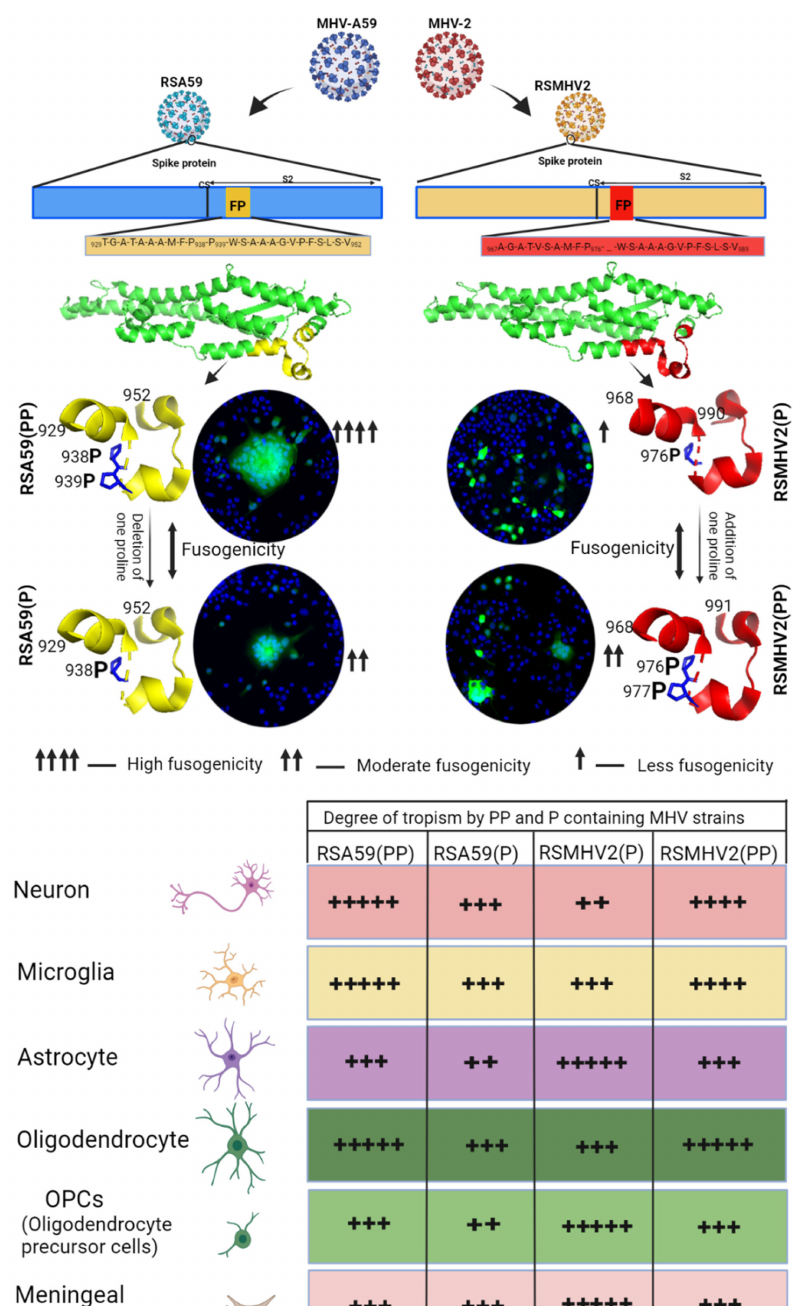
Figure 12. The monomeric model of the S2 subunit of Spike protein of MHV-A59, MHV-2 with their fusion peptides, the mutation and their fusogenicity and neuro-glia tropism. The cartoon diagram showed that RSA59(PP) and RSMHV2(P) were recombinant viruses engineered from MHV-A59 and MHV-2 respectively. Monomeric model of S2 subunit of MHV-A59/RSA59(PP) amino acid residues (871-1116) from PDB structure 3JCL and the S2 subunit of MHV-2 built from 3JCL for MHV-2/RSMHV2(P) amino acid residues (911-1153). The fusion peptide region highlighted in yellow and red for RSA59(PP) and RSMHV2(P) respectively, with the central proline shown in stick model. The deletion of one proline from RSA59(PP) and addition of one proline to RSMHV2(P) resulted into RSA59(P) and RSMHV2(PP), respectively. The fusogenic ability of the four viruses in N2A (neuroblastoma) cell line is indicated by up arrows with strength given in legend. The differential degree of neuroglia tropism by the four viruses is presented in table denoted by lowest degree of tropism by + and highest degree of tropism by